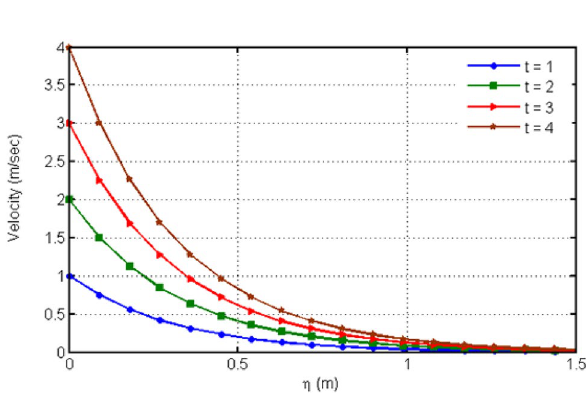
Figure 6. Variation in velocity profile for diverse values of time t .